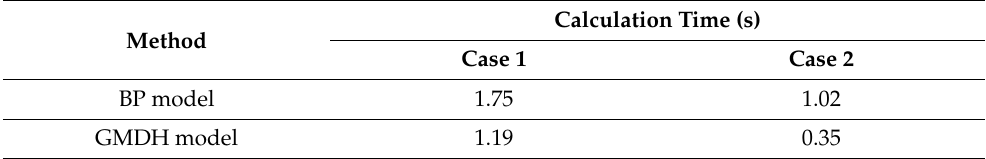
Table 2. The comparison of calculation time.